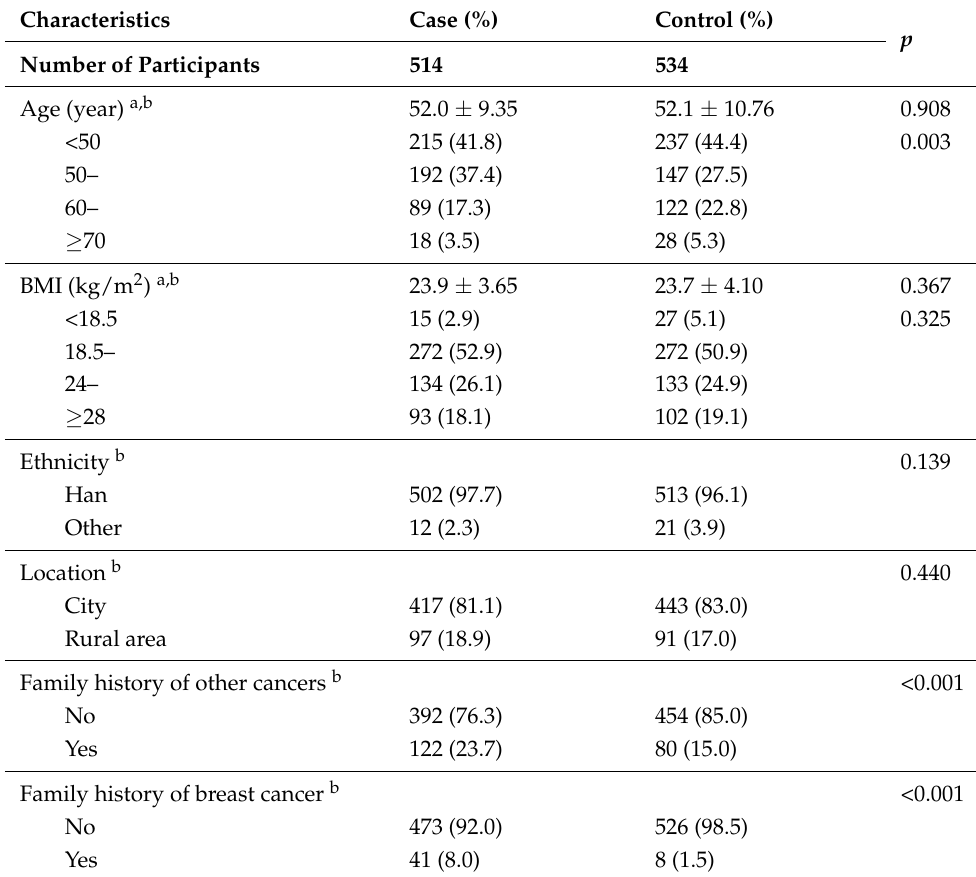
Table 1. Demographic characteristics of breast cancer patients and